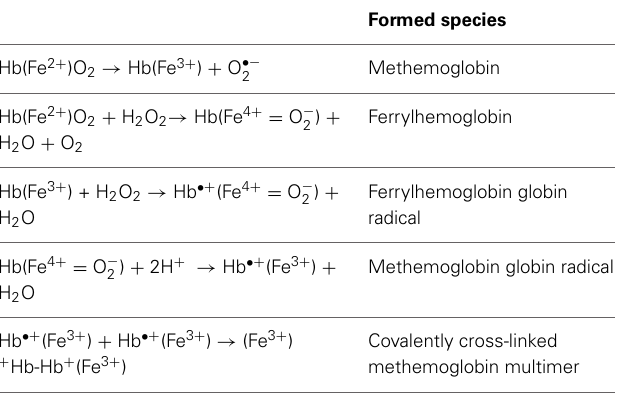
Table 1 | Routes of hemoglobin